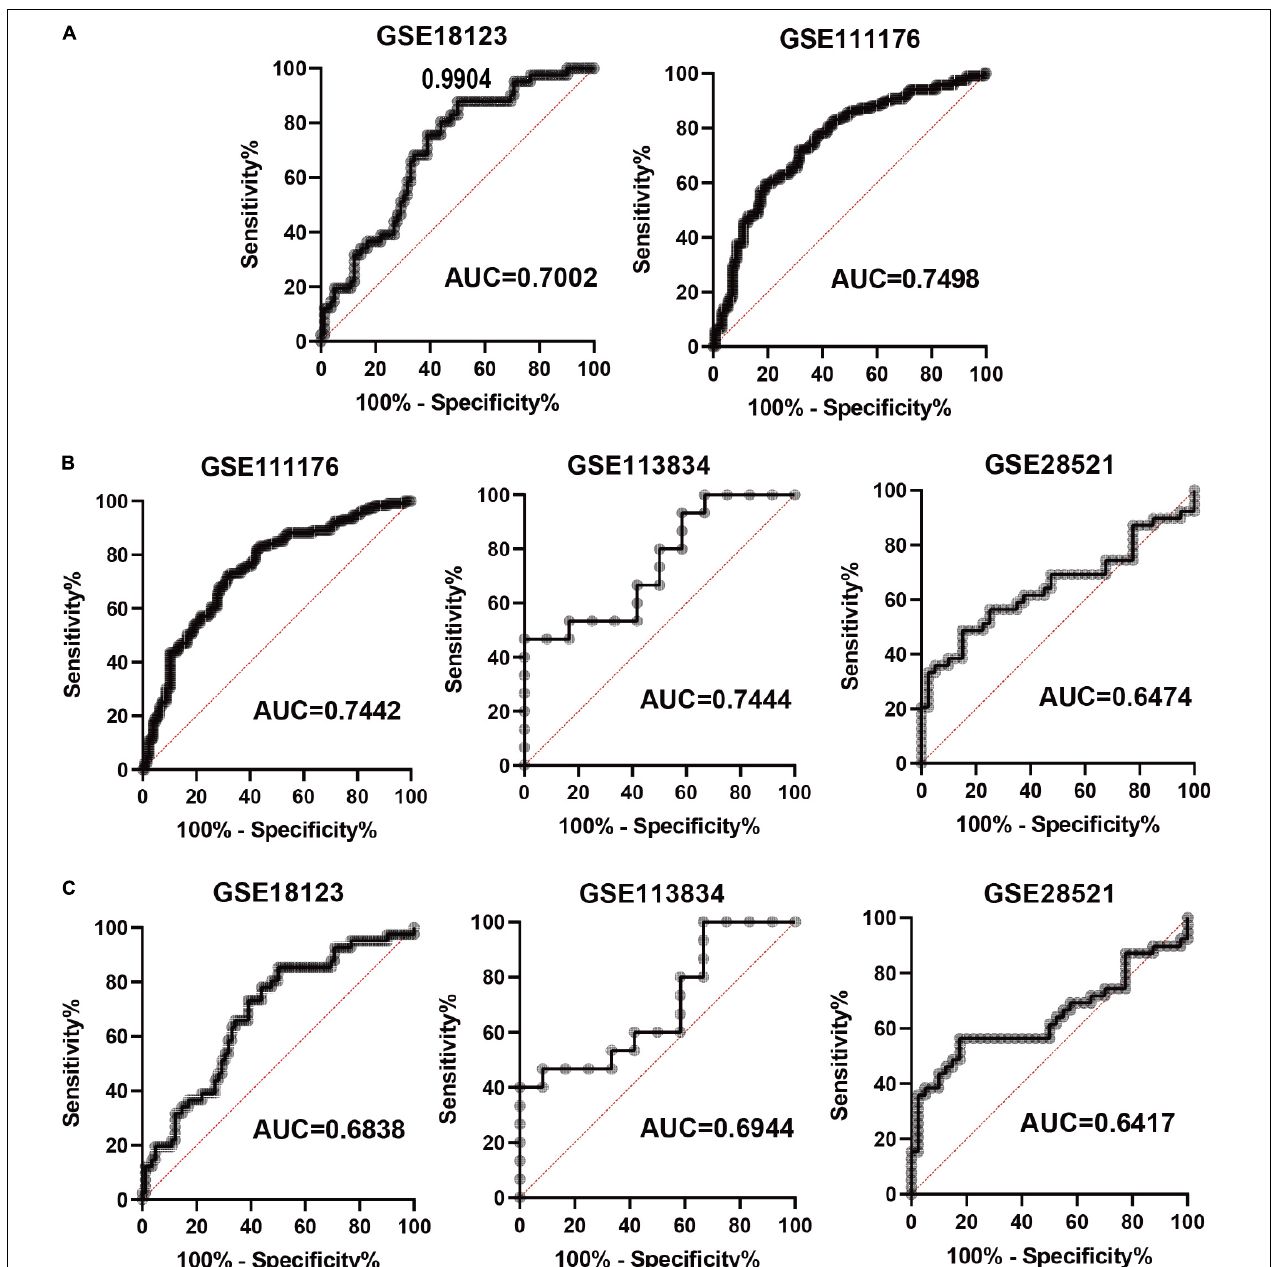
FIGURE 5 | Evaluation of the constructed diagnostic model. (A) ROC curves in development datasets. (B) ROC curves in validation datasets based on the model from GSE18123. (C) ROC curves in validation datasets based on the model from